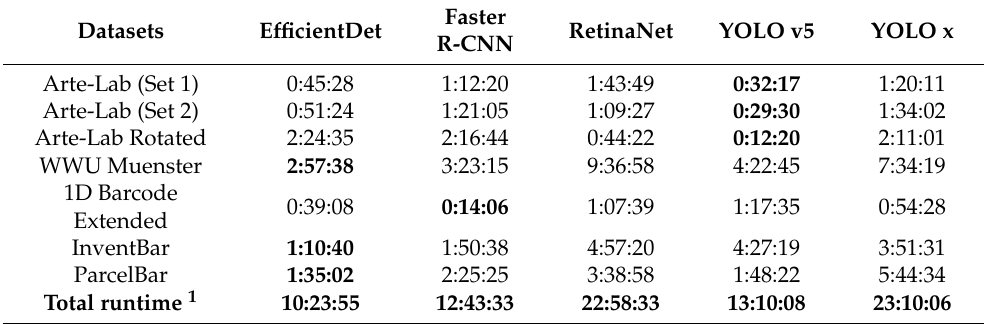
Table 7. Runtime performances of D-CNN methods at the optimal detection accuracy.